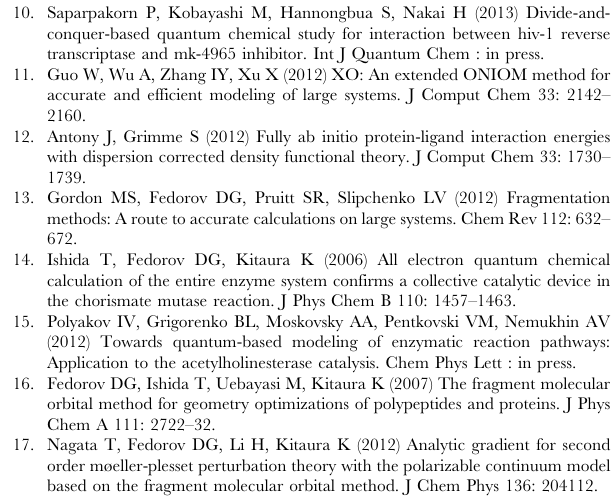
Figure S1 Reaction barrier calculated at the MP2/cc- pVDZ:EFMO-RHF/6-31G(d) level of theory for EFMO:S using R resdim ~ 1 : 5 and FDD (modfd =3). This snapshot shows the effect of not having enough flexibility in the active region around the substrate.